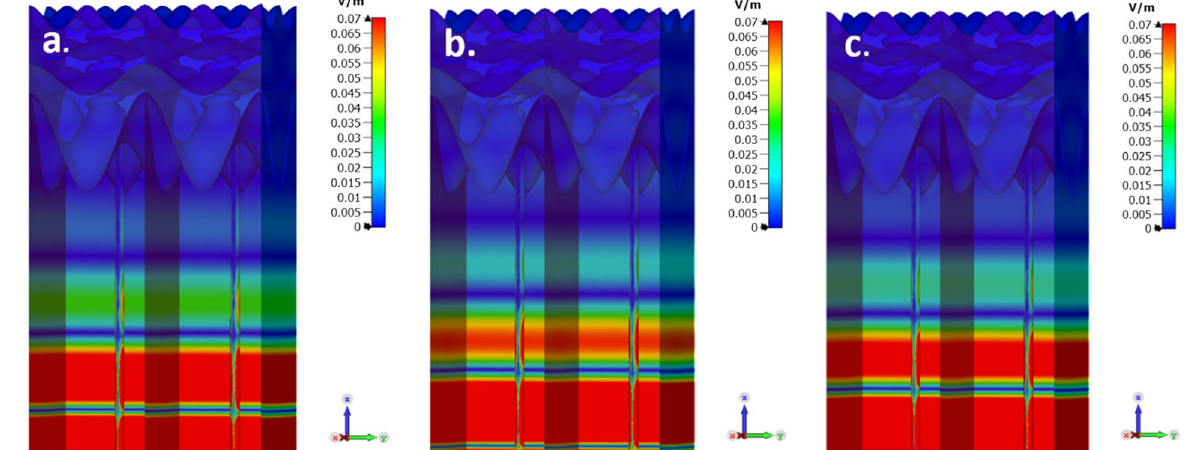
Figure 8. Fixed frequency of 550 GHz and different phases ( a ) 0, ( c ) 90° and ( f ) 225°) out of the nine which were simulated. In the scale-bar, all values above 0.07 V/m are marked in Red color. This figure was generated using CST STUDIO SUITE v2021 30 , https:// www. 3ds. com/ produ cts- servi ces/ simul ia/ produ cts/ cst- studio-